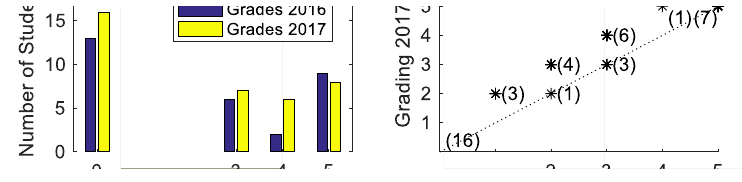
Fig. 3. CT2 grading comparison: a) grade histograms and b) grading system comparison using the points from the final exam in 2017 (the number of students in